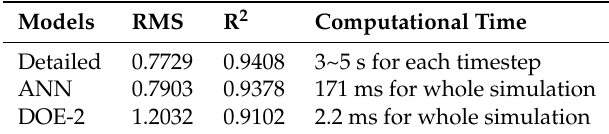
Quantitative measures of various models based on modeled and tested supply water